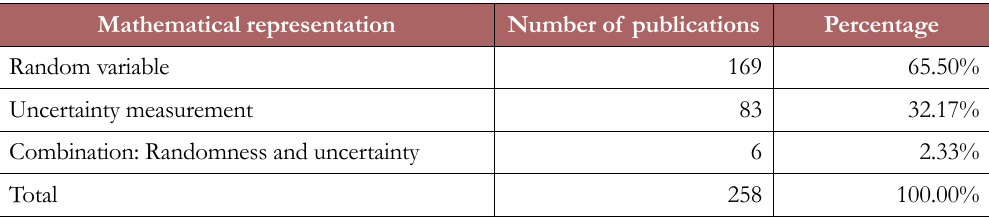
Table 1. Mathematical representation of the activities